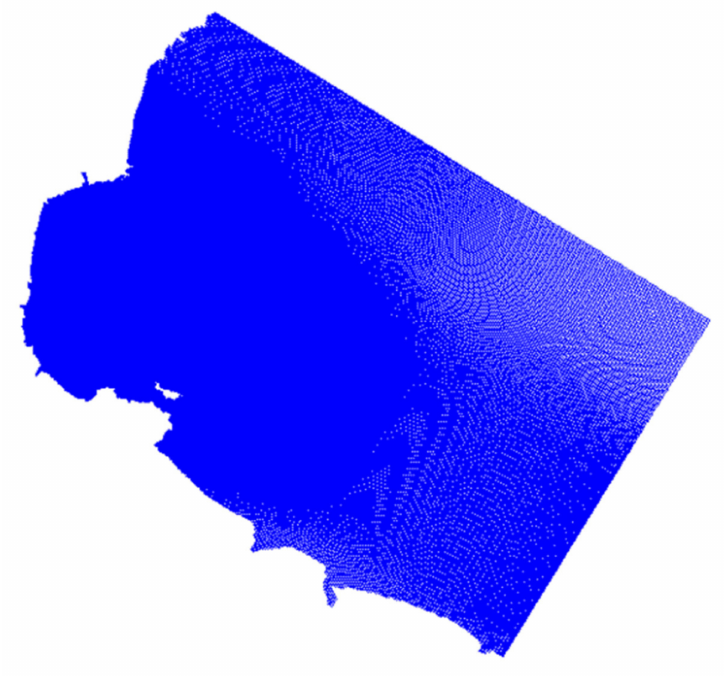
Figure 2. Grids for numerical simulation